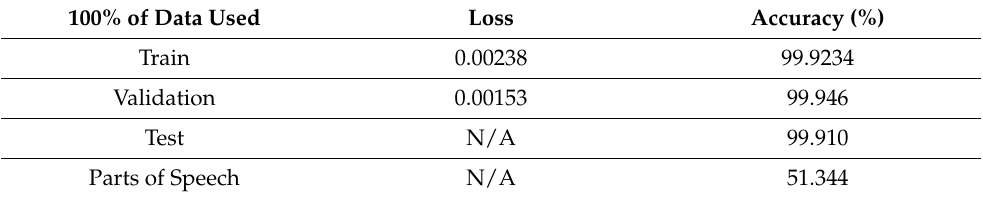
Figure 9. From left to right: The relationships between the number of samples used for training, the batch accuracy, the training loss, and the final accuracy. Table 2. Training results from combining the datasets and splitting train/test along tokens.